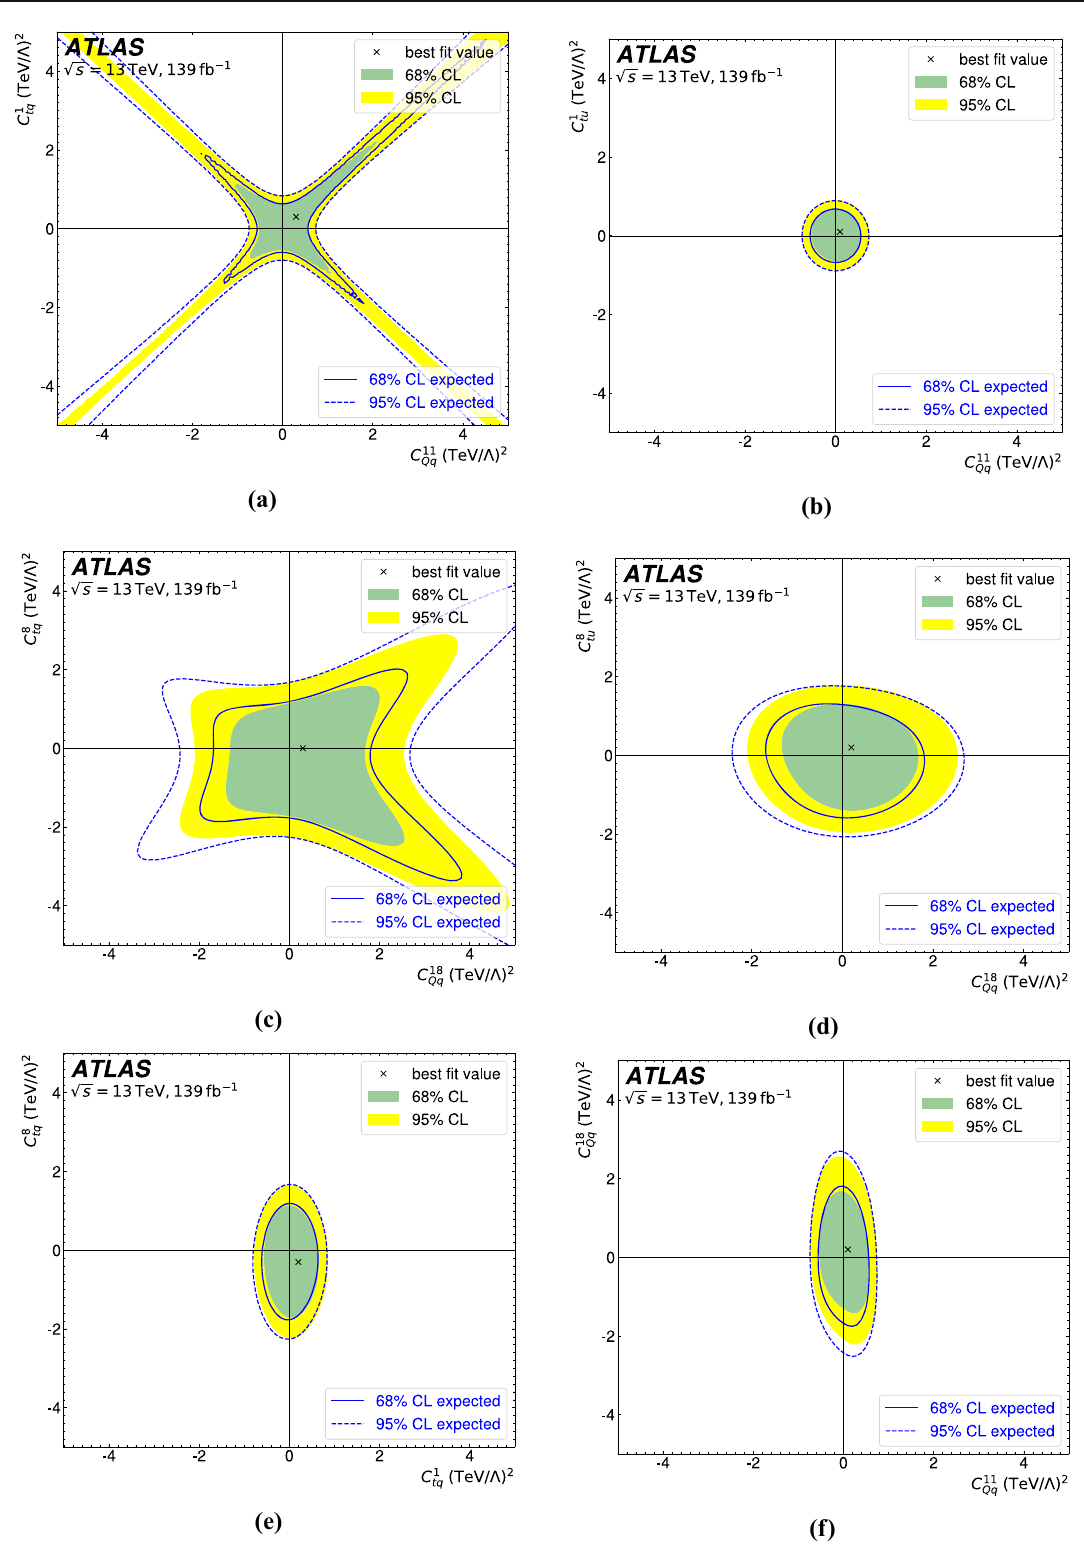
Fig. 10 Bounds on Wilson coefficients from two-parameter fits of the energyasymmetry A E inallthree θ j bins.Theinnergreenandouteryel- low areas show the 68% and 95% CL limits obtained from the measured